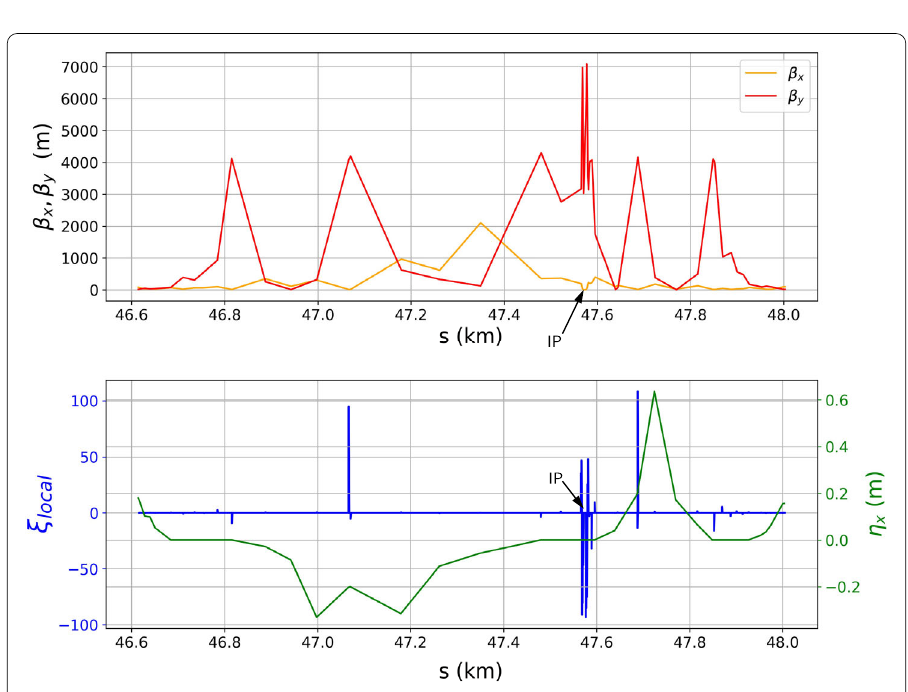
Figure 1 Optics near the IP for the 182.5 GeV ttbar lattice. Top plot shows the beta functions in the IR, and the bottom plot shows the local chromaticity ( ξ local , Eq. (3)) and the horizontal dispersion ( η x )